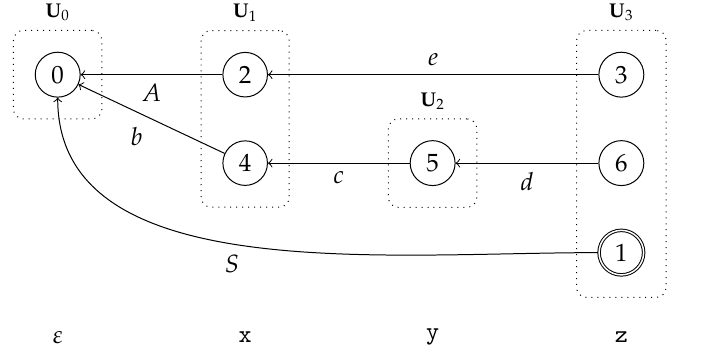
“ M b | M c | M d | M e | M $ for the specification Ξ in (3). $